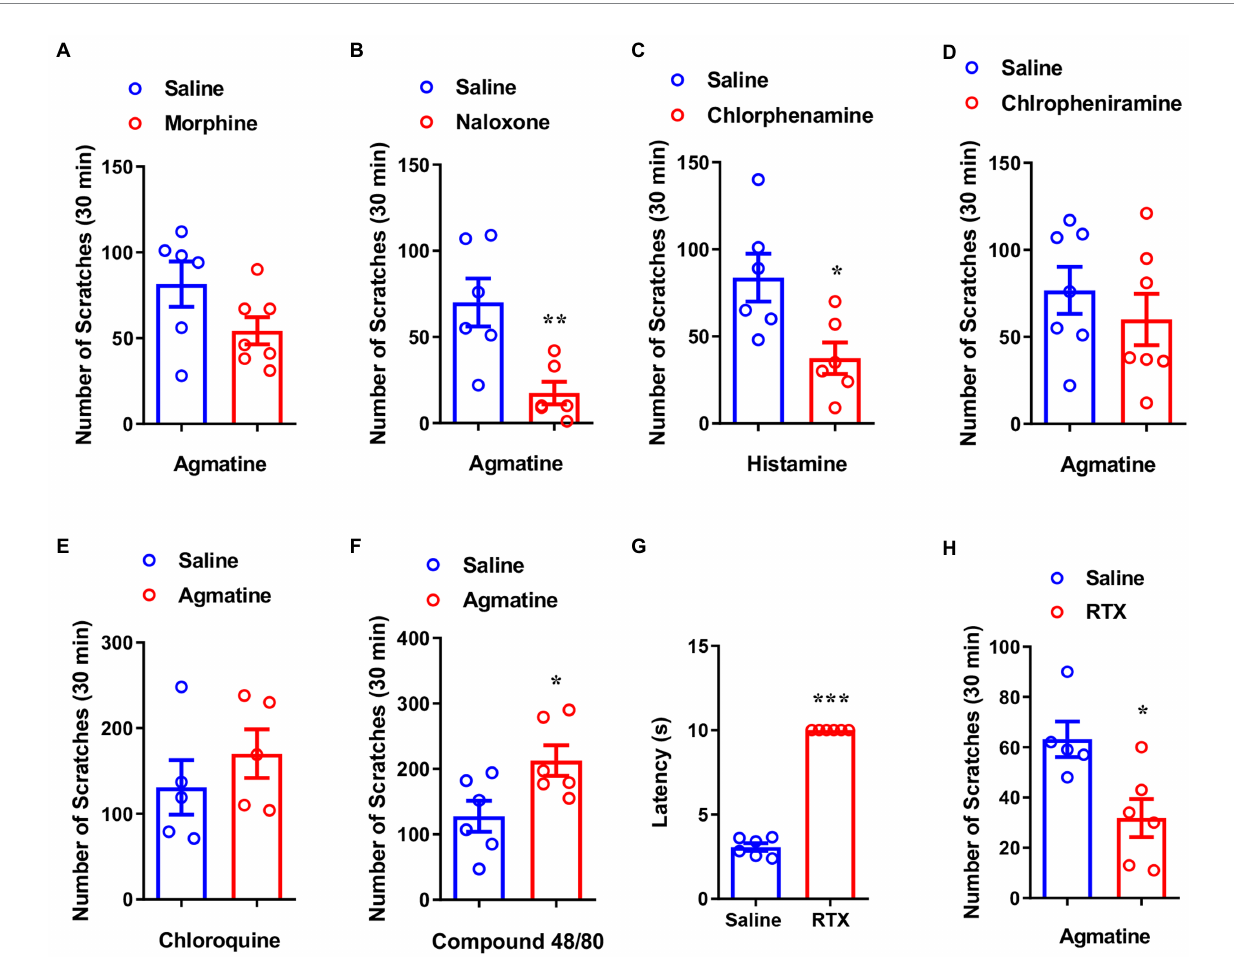
FIGURE 2 Capsaicin-sensitive nociceptors are required for agmatine-induced itch. The effects of morphine (1 mg/kg, i.p.) (A) and naloxone (1 mg/kg, i.p.) (B) on scratching behavior induced by agmatine (500 μ g) in mice (* p < 0.05, ** p < 0.01, *** p < 0.001 vs. agmatine, unpaired Student’s t test; n = 6–8 per group). (C) The effects of chlorpheniramine (1 mg/kg, i.p.) on scratching behavior induced by histamine in mice (* p < 0.05, ** p < 0.01, *** p < 0.001 vs. histamine, unpaired Student’s t test; n = 6 per group). (D) The effects of the H1R antagonist chlorpheniramine (1 mg/kg, i.p.) on scratching behavior induced